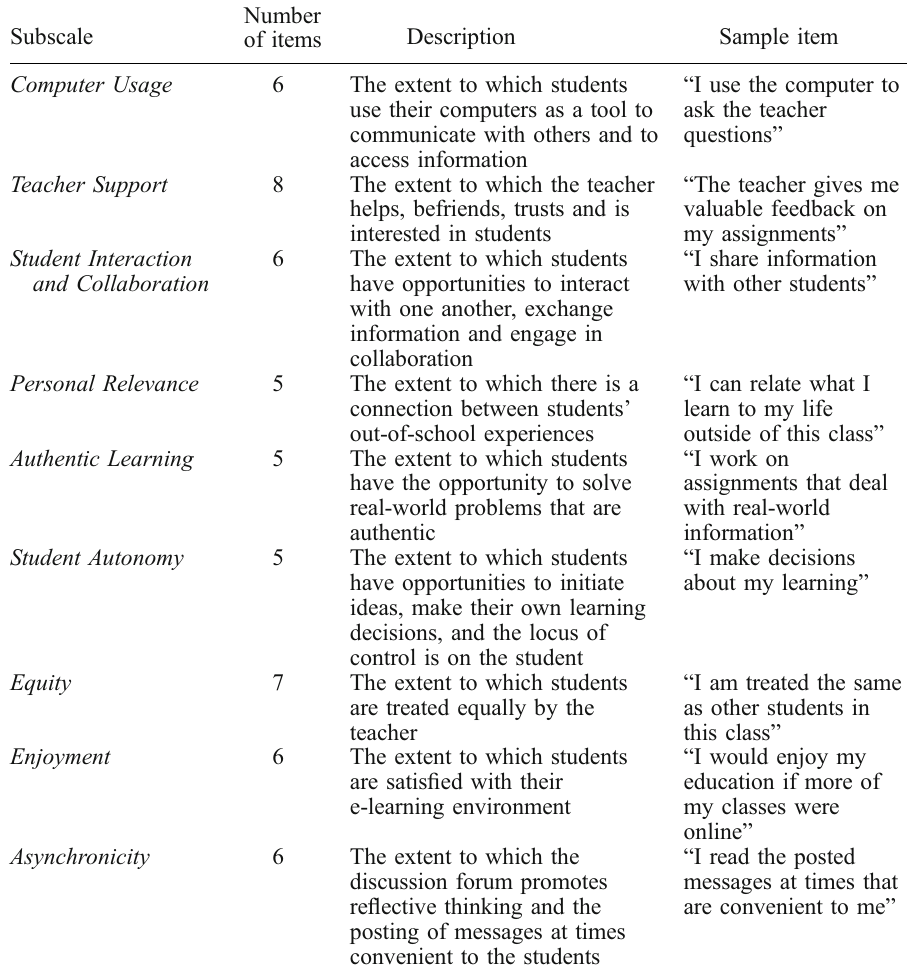
Table 1. Descriptions and examples of the nine OLES subscales.